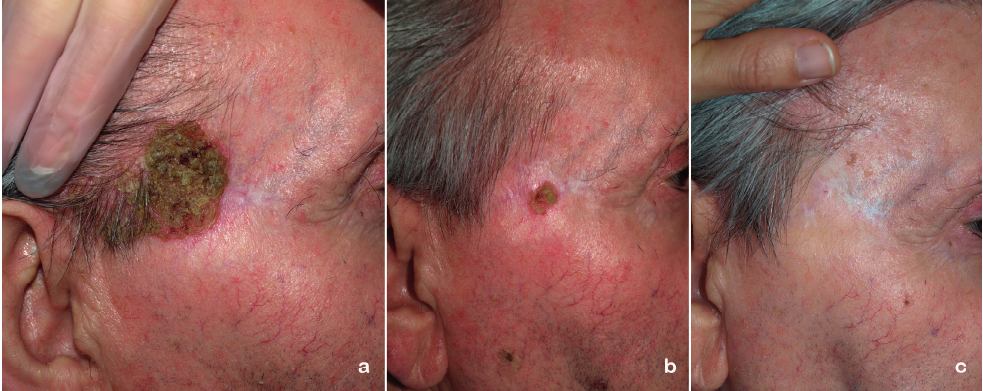
Figure 3. ( a ) Patient with recurrent Bowen disease after surgery and a cycle of methyl-aminolevulinate photodynamic therapy (MAL-PDT) (two sessions one week apart using 37 J·cm − 2 Aktilite ® (Galderma SA, París, France); ( b ) Tumor persists one month after a second cycle of MAL-PDT and before treatment with topical imiquimod, five days per week during six weeks. ( c ) No recurrence after nine months of